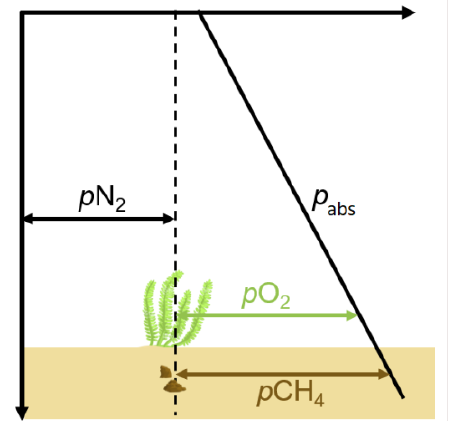
Figure 5. Gas pressure against depth in an idealized lake, gas pressure of argon is included in the N 2 value, gas pressures of other gases and water vapor pressure are